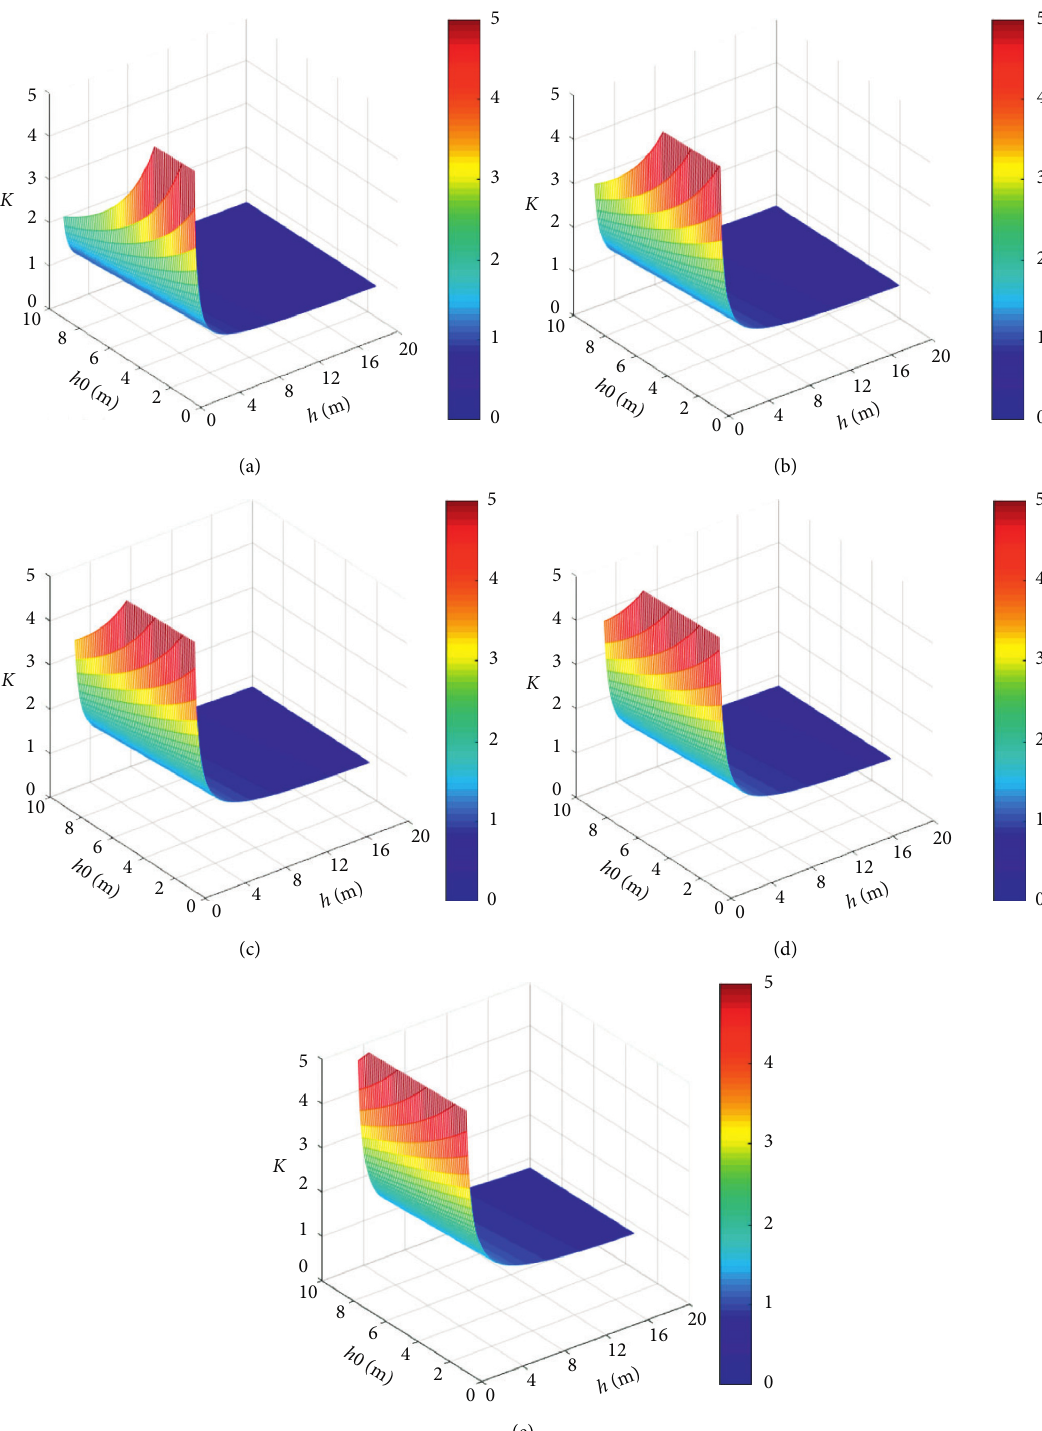
Figure 9: Limit equilibrium criterion of short cantilever rock beam structure. (a) M � 1.5m value, (b) m � 2.1 m value, (c) m � 2.5m value, (d) m � 2.8m value, and (e) m � 3.5m